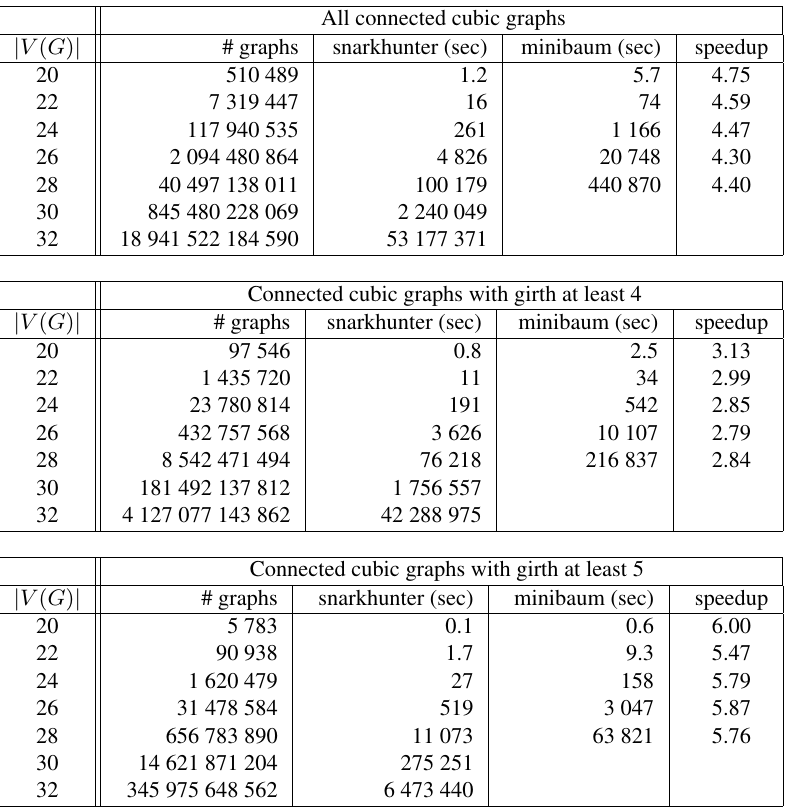
Table 2: Counts and generation times for classes of cubic graphs. Times are for C code compiled by gcc and run on an Intel Xeon L5520 CPU at 2.27 GHz. They include writing the graphs to a null device. As minibaum depends more strongly on memory performance than snarkhunter, the speedup in the last column depends strongly on the actual processor architecture. For other Intel Xeon processors it was considerably larger than given in the